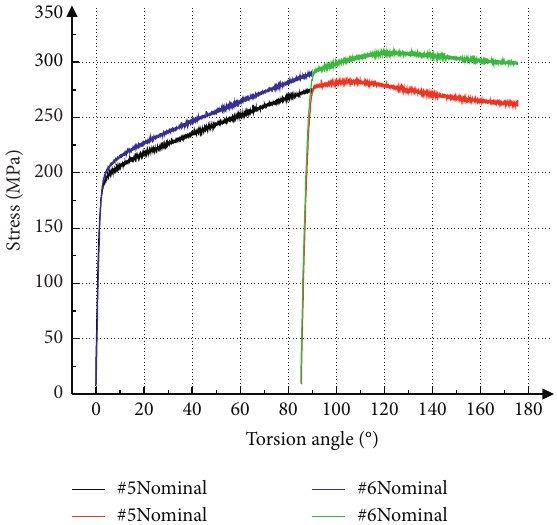
Figure 6: Shear stress-rotation